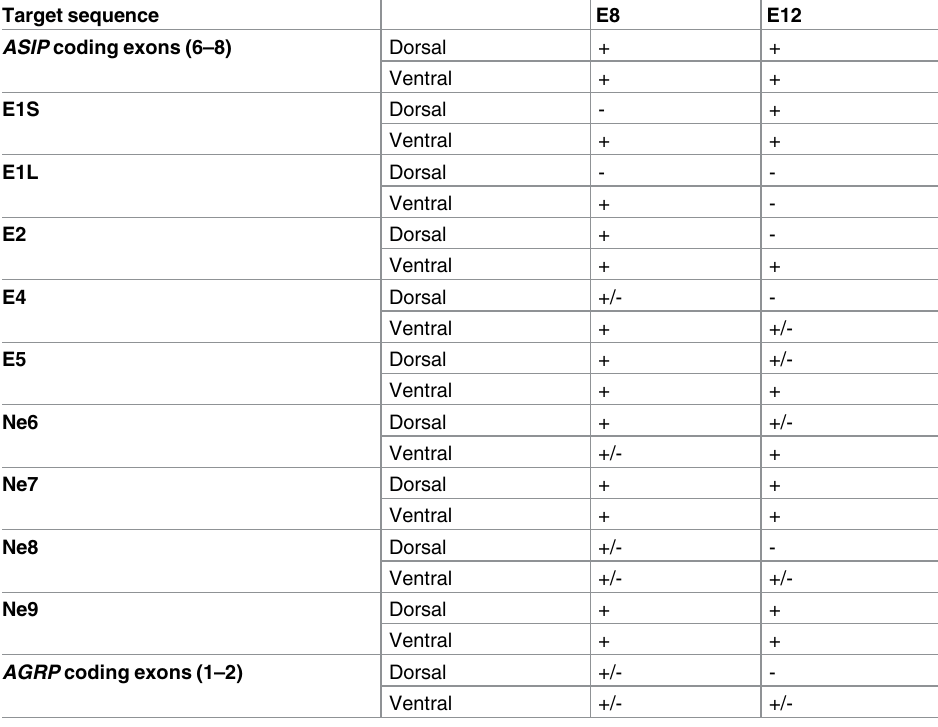
“+” = present, “-” = absent, “+/-” = variable expression.